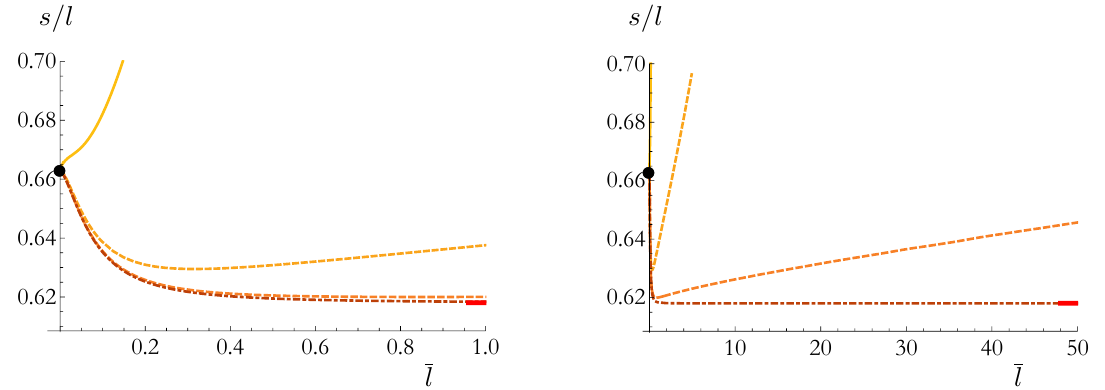
Figure 12. Ratio of the values of the width of strips l which are separated by a distance s at the point, where mutual information vanishes. Right plot extends the range of the left plot to larger strip widths. Notice that the numerics match analytic results both for small l at the UV (4.3) and large l at the IR (4.2). See legends in figure